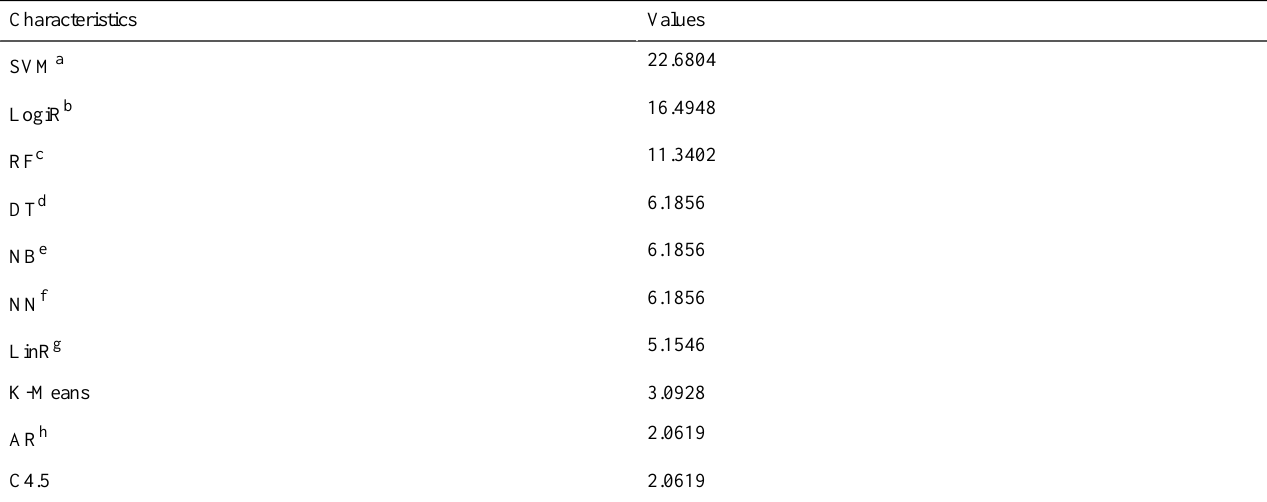
Table 3. Classifier